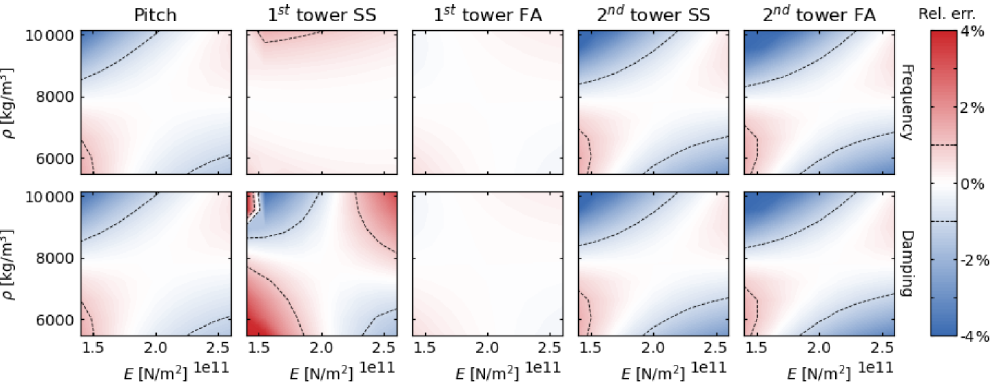
Figure 5. Relative errors in the system frequencies and damping ratios between the direct and interpolation methods as a function of tower properties (Young’s modulus, E , and mass density, ρ ). Top panels: relative error in damped frequencies. Bottom panels: relative error in damping ratios.